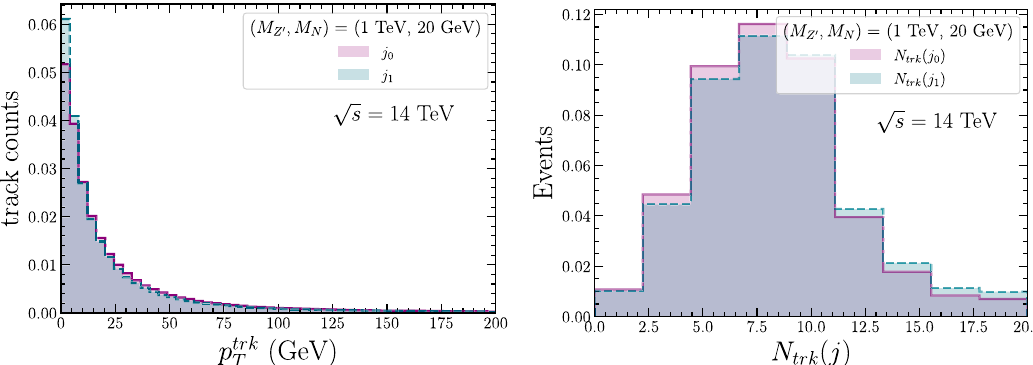
Fig. 10 Left panel: p T of tracks associated with leading and sub-leading jets at HL-LHC. Right panel: number of tracks associated to j 0 , 1 at HL-LHC